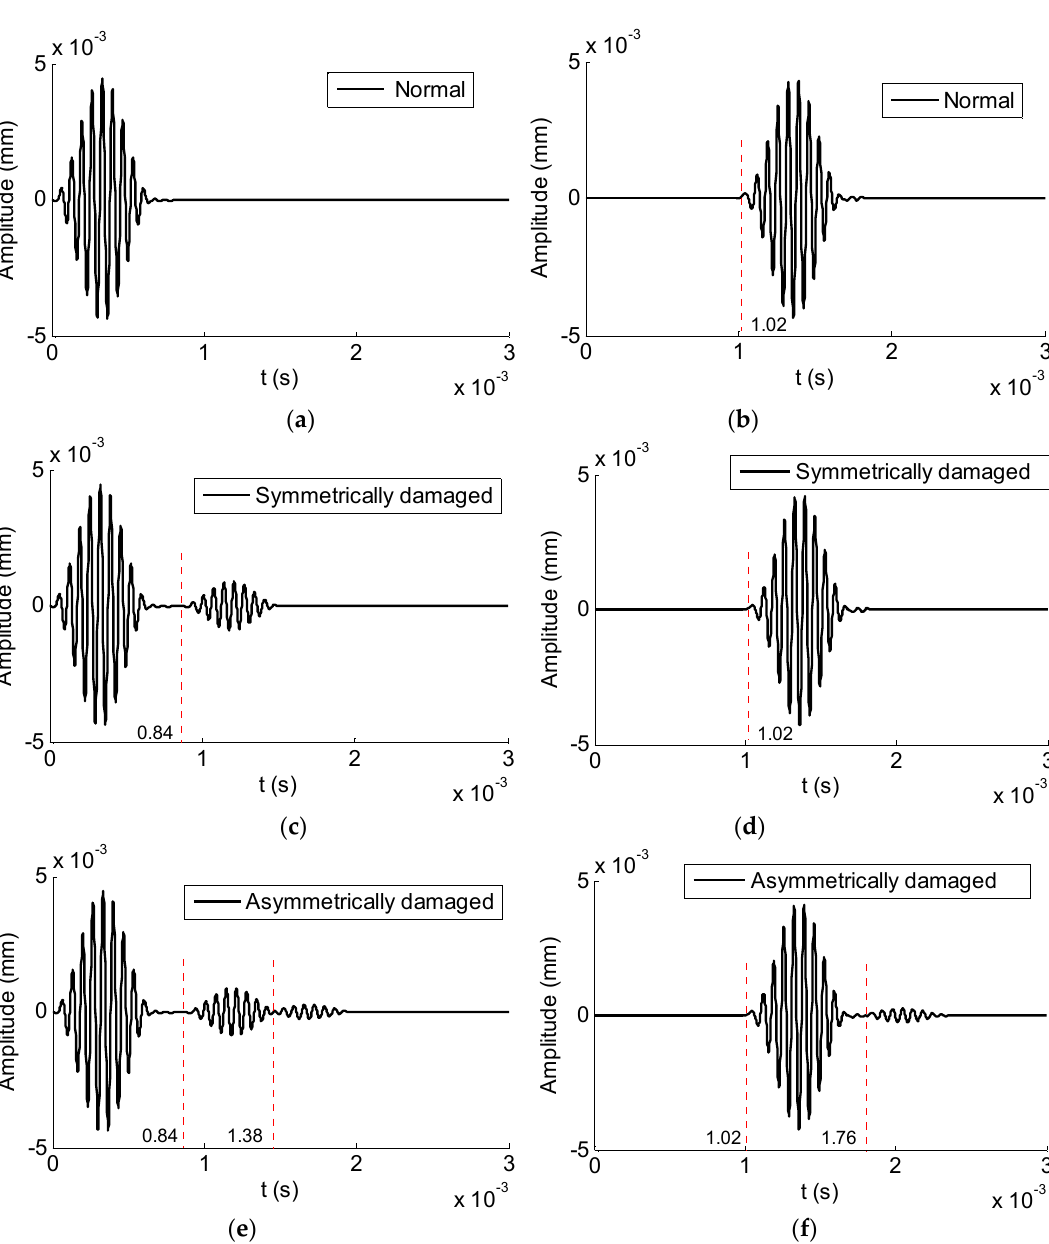
Figure 14. Time domain waveforms received from hexagonal drill pipes under the excitation of axial surface traction at the center frequency of 15 kHz: ( a ) and ( b ) reflected and transmitted waves from a normal hexagonal drill pipe, respectively; ( c ) and ( d ) reflected and transmitted waves from a symmetrically damaged hexagonal drill pipe, respectively; and ( e ) and ( f ) reflected and transmitted waves from an asymmetrically damaged drill pipe, respectively.